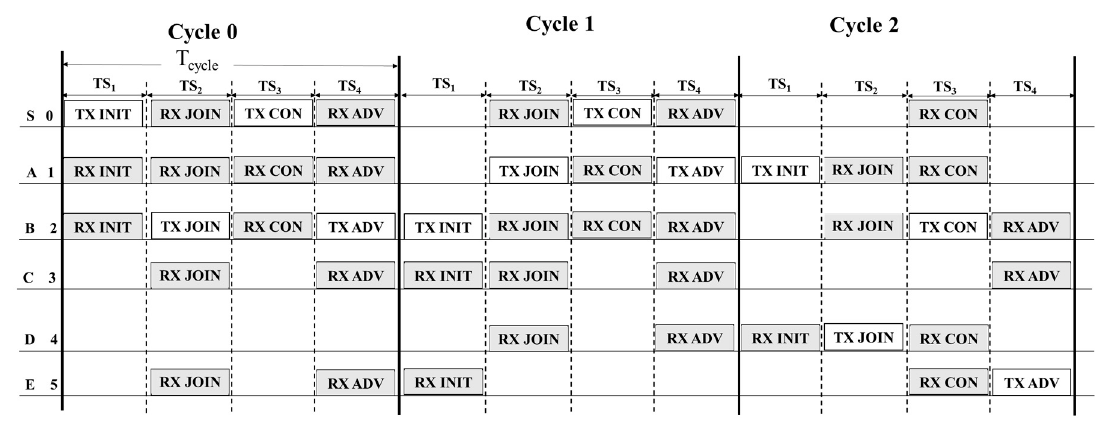
Figure 6. All the nodes’ operations in the NCP process for the example network in Figure 5.